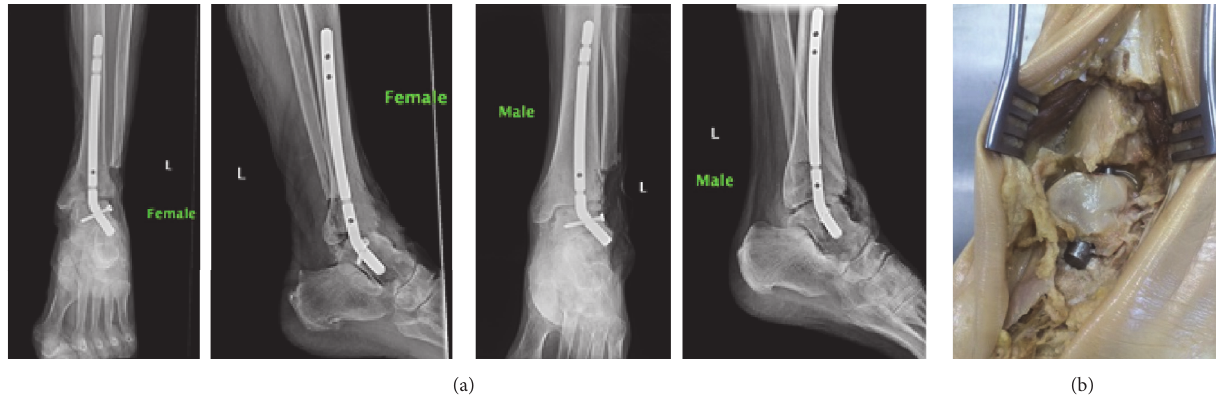
Figure 10: (a) AP and lateral radiographs with intramedullary device in place in appropriate coronal alignment. (b) Cadaveric specimen with intramedullary device flush in sinus